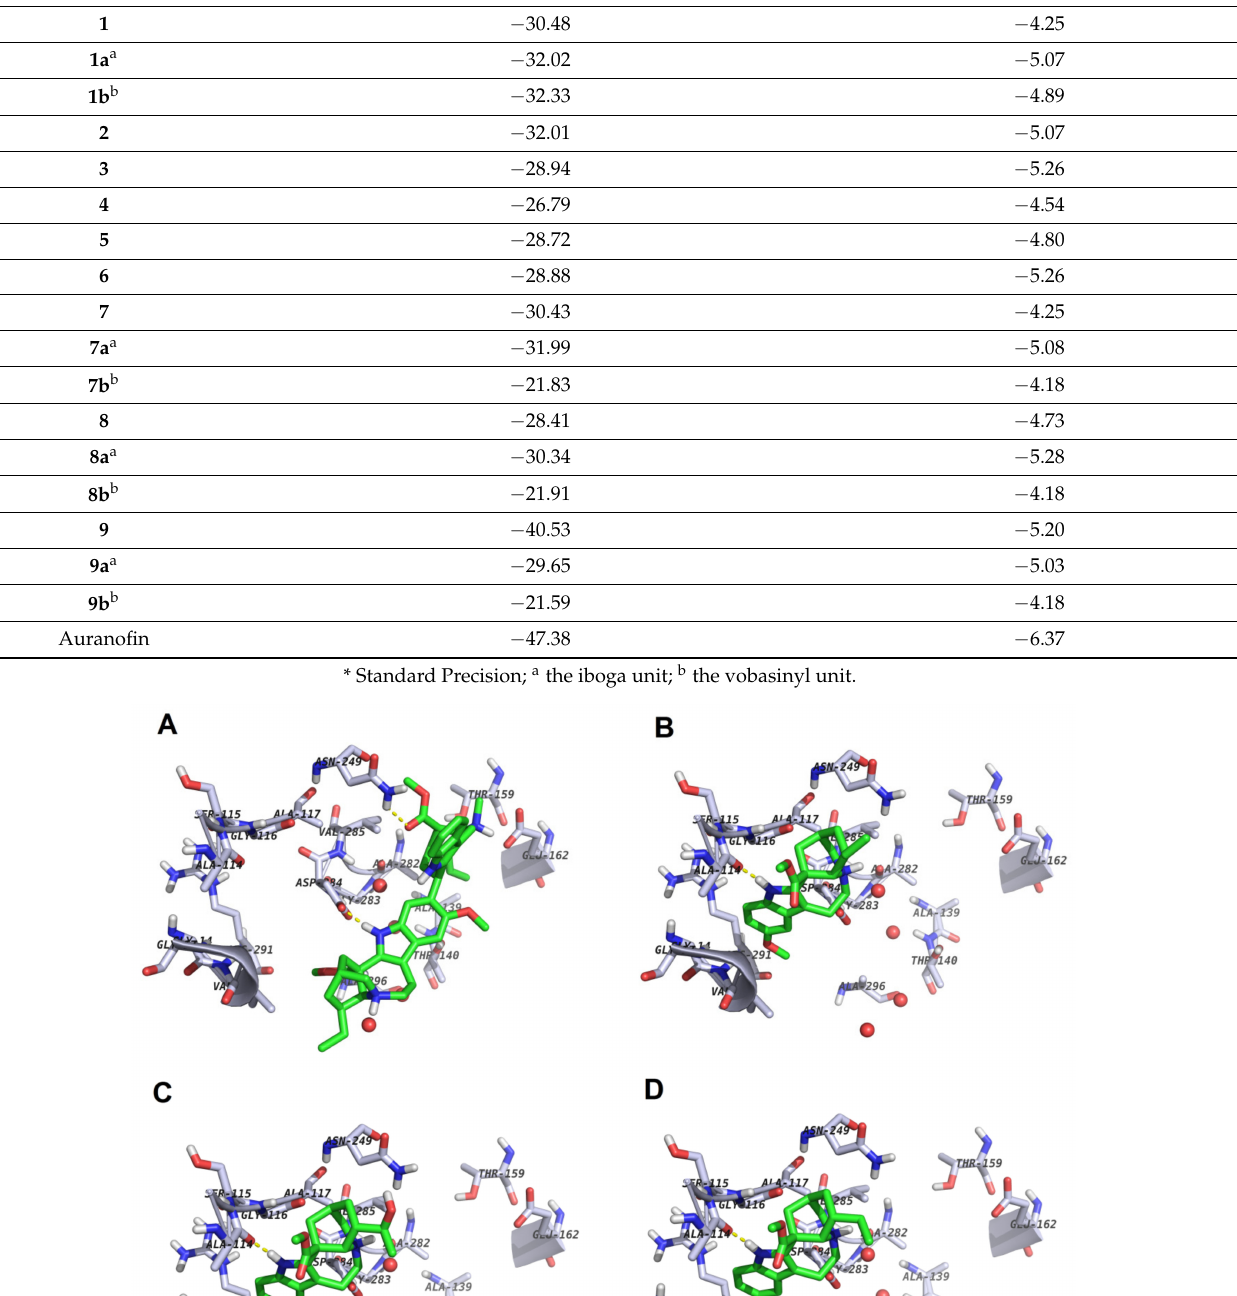
Table 5. Docking scores of the isolated compounds and their moieties towards the O. ochengi thioredoxin reductase target and minimization energies of the protein–ligand complexes (including electronic, solvation and van der Waals components). Compound Minimization Energy (Amber12, kcal/mol) Docking Score (SP *, kcal/mol)